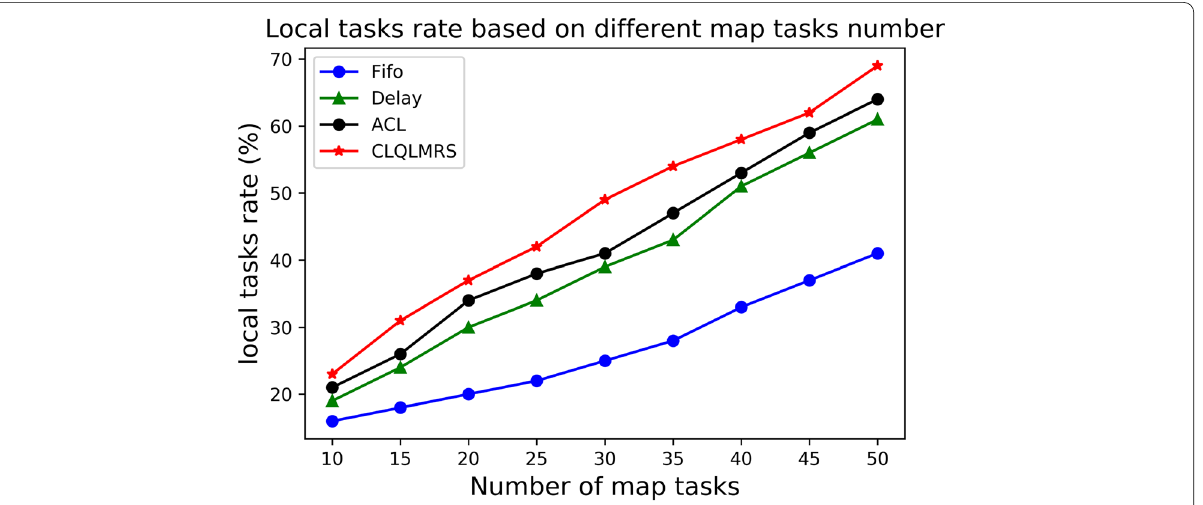
Fig. 7 Local tasks rate based on number of Map